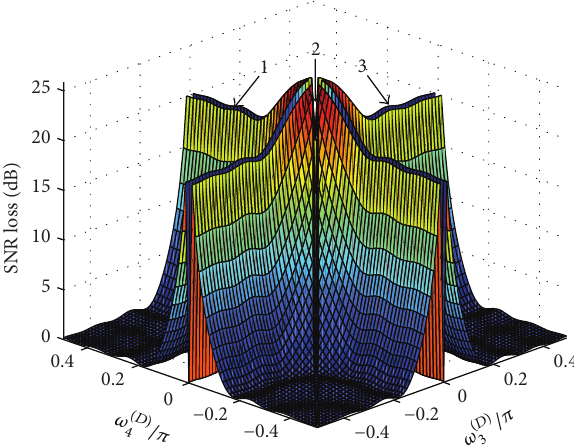
Figure 6: The Doppler frequencies of the two clutter sources versus the SNR loss.